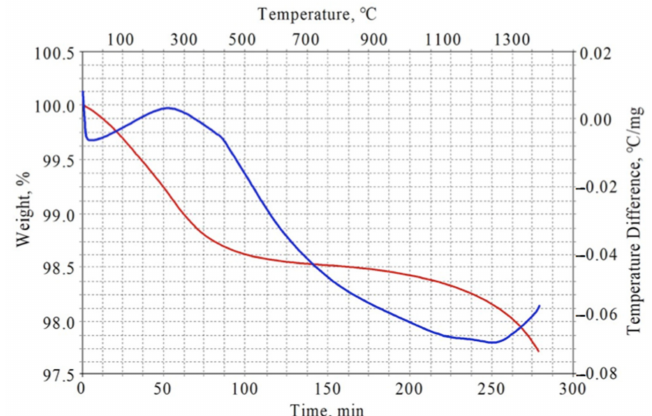
Figure 1. DTA (blue) and TG (red) curves of Y 2 O 3 -TiO 2 powder mixtures.